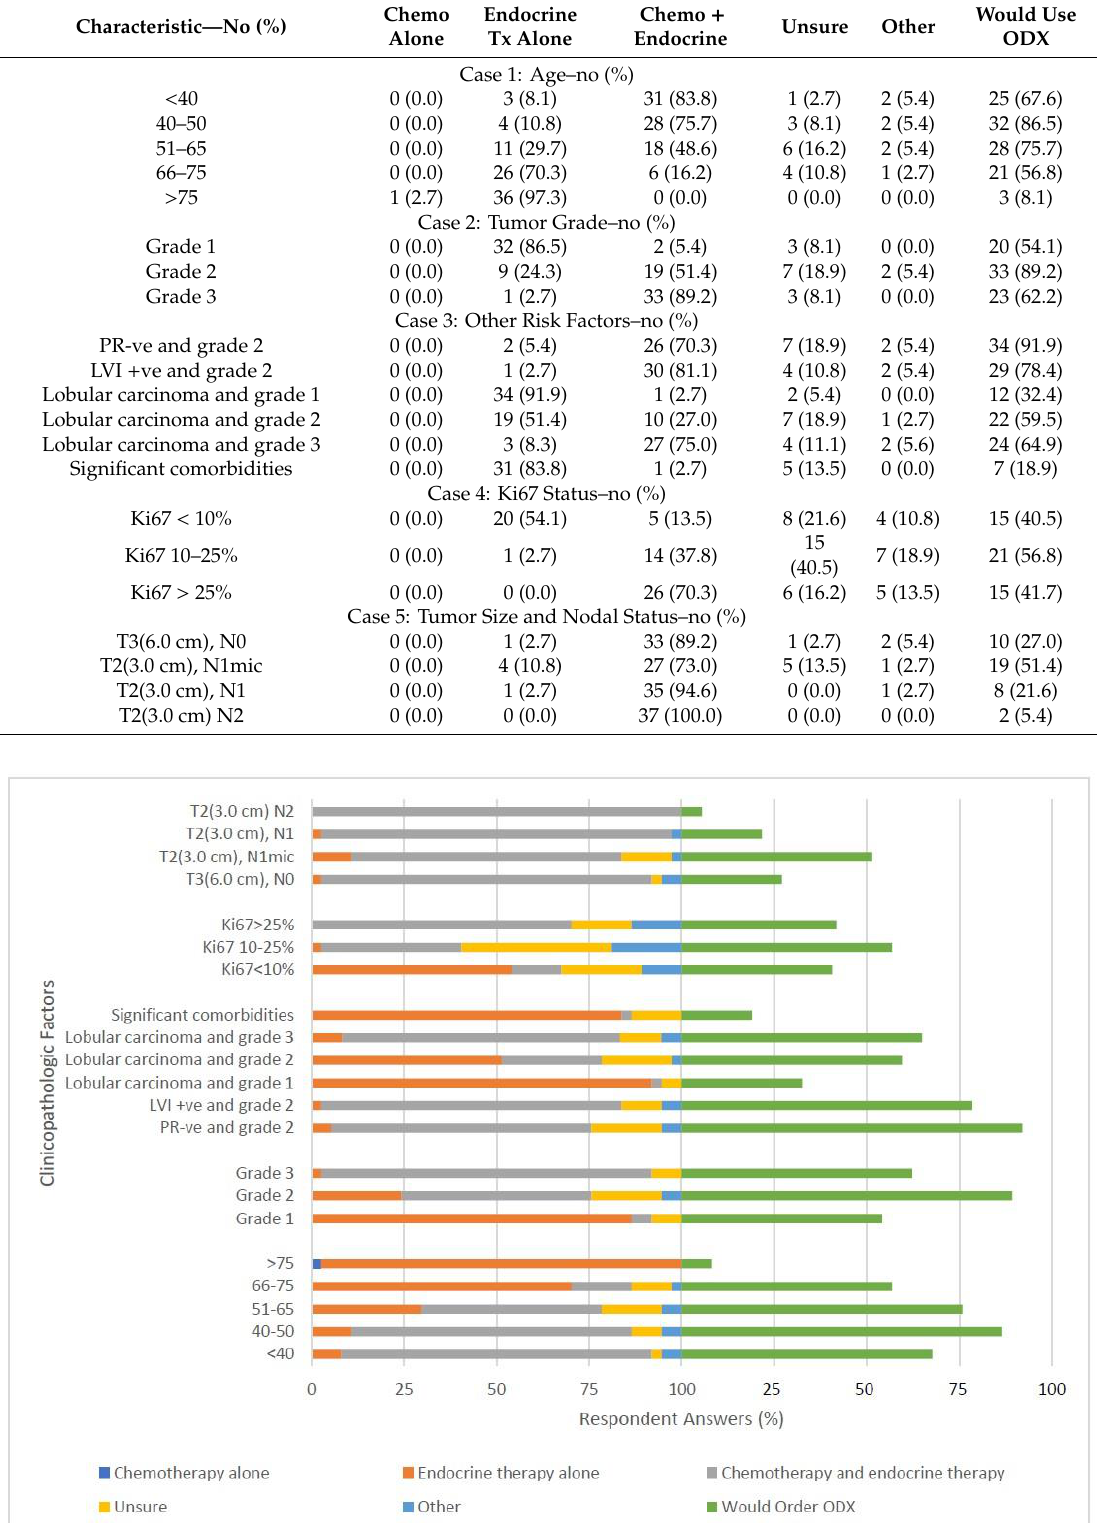
Table 4. Respondent treatment decisions based on several di ff erent theoretical case scenarios. The respondents were also asked whether or not they would order ODX in the various scenarios.